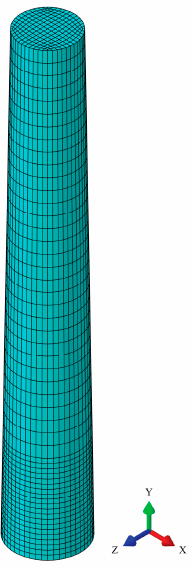
Figure 13. The finite element mesh of the cantilever beam. Table 5. The number of elements, nodes, and degrees of freedom of the analyzed models of the cantilever